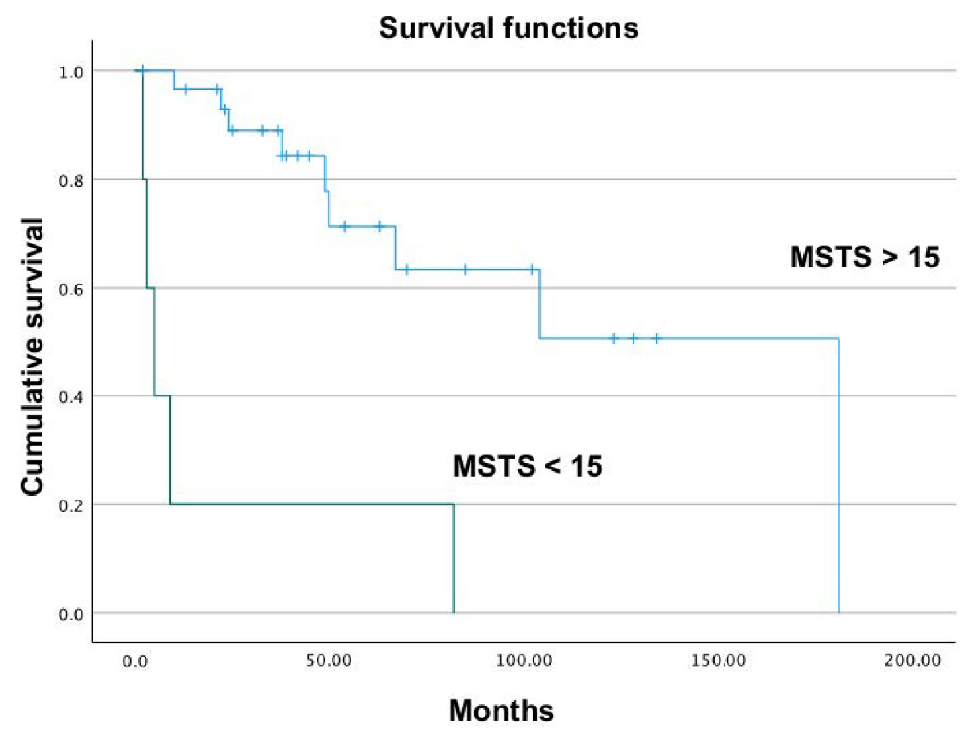
Figure 4. Lower MSTS (Musculo-Skeletal Tumor Society) score showed a significantly lower survival time.